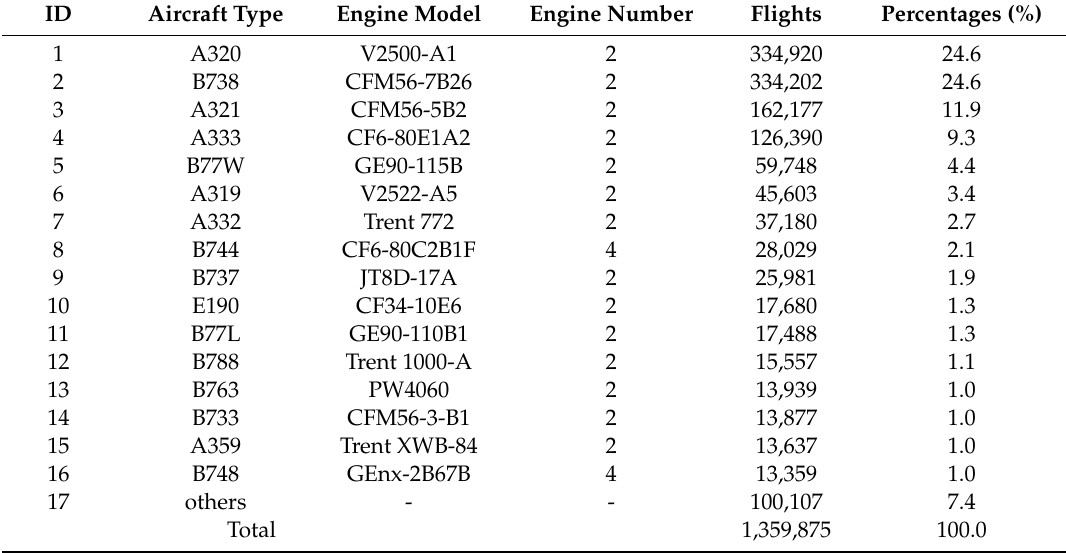
Table 2. Aircraft types in the GBA airport cluster in